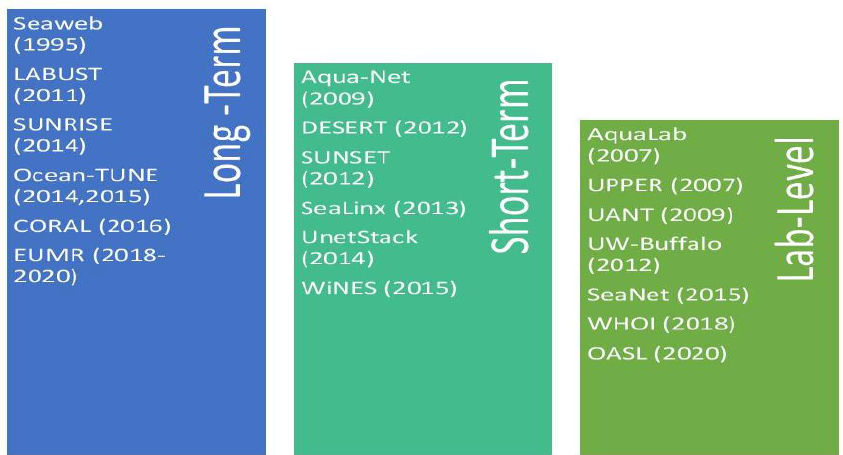
Figure 3. State-of-the-art Platforms in